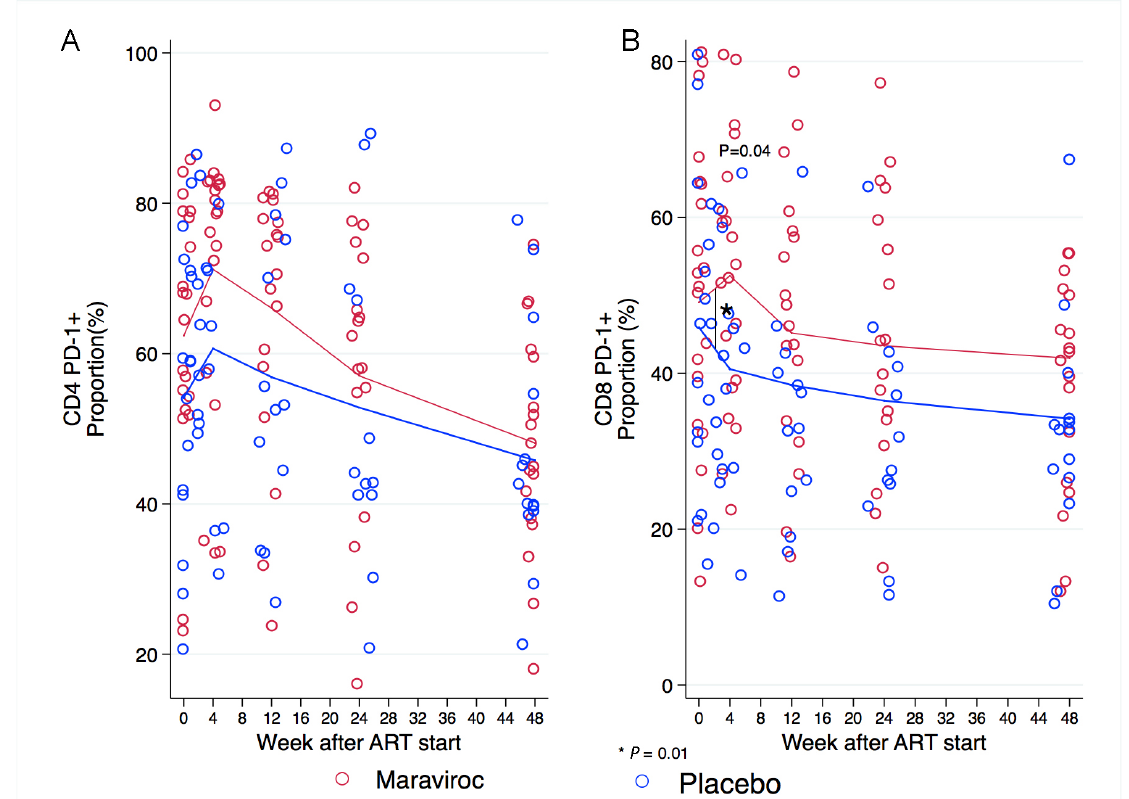
Figure 6. Proportion of CD4+ and CD8+ cells expressing PD-1 at baseline, weeks 4, 12, 24, and 48. The proportion of CD4+ cells expressing PD-1 increased in both arms during the first 4 weeks of treatment and then decreased throughout follow-up until the end of the study. B) The number of CD8+ cells express- ing PD-1 at baseline was similar across treatment arms. The proportion of CD8+ cells expressing PD-1 was higher at week 4 in participants receiving maraviroc than in those receiving placebo. These proportions decreased in both treatment arms afterwards. Note that the scale in the Y-axis differs for each panel in the figure. Comparisons between treatment arms at measurements are depicted in the graphic when P < 0.05. Comparisons in the rate of change between 1 time point to the next are indicated by a vertical line and asterisk when P < 0.05. The P -values were derived from mixed linear models using linear combination of coefficients after model